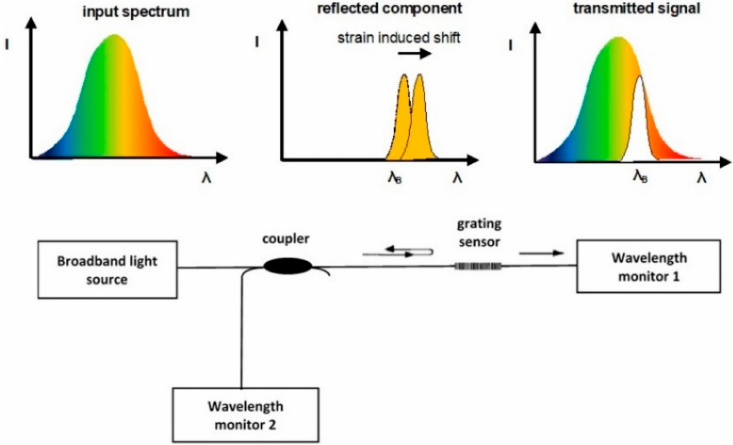
Figure 2. Working principle of FBG sensors and associated inspection